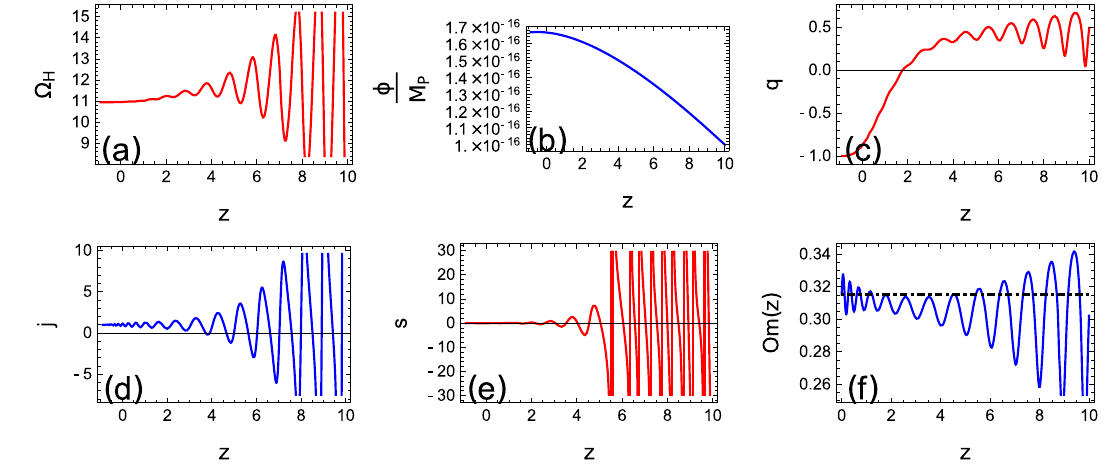
Fig. 8 Evolution of the density parameter Ω H and scalar field φ for the f ( R ) gravity with GB terms and interacting fluids taking α = 0 . 9 and η = − 0 . 006. Cosmological parameters are also plotted as functions of redshift z Fig. 9 Variation of dark energy variables, the effective EoS parameter w ef f (right) and DE Density parameter Ω DE (left) with interaction considering α = 0 . 9 and η = − 0 . 006